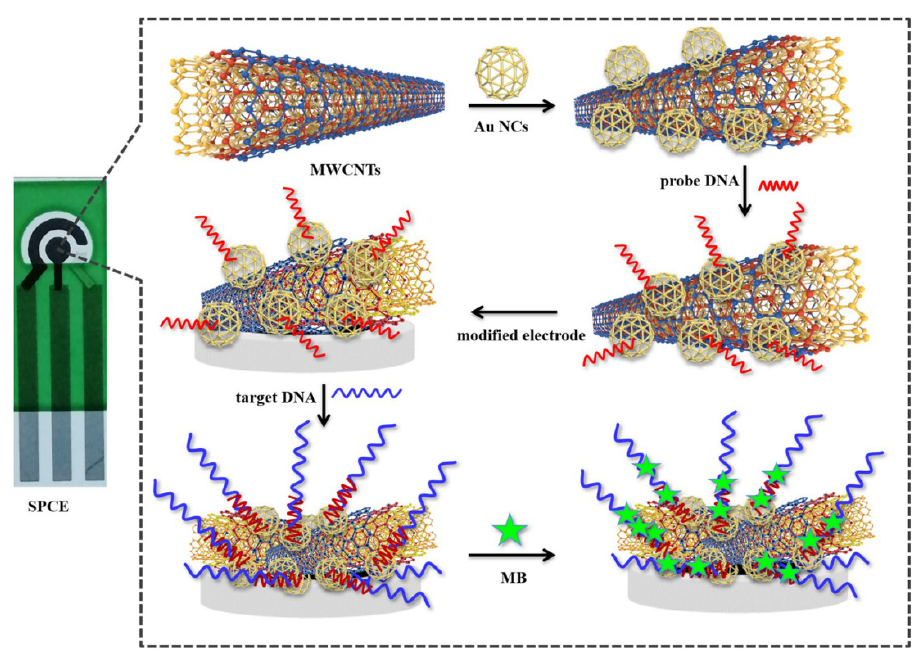
Figure 3. Schematic representation of the SPCE electrochemical DNA biosensor to detect lncRNA biomarker MALAT1. Reprinted from ref. [40].